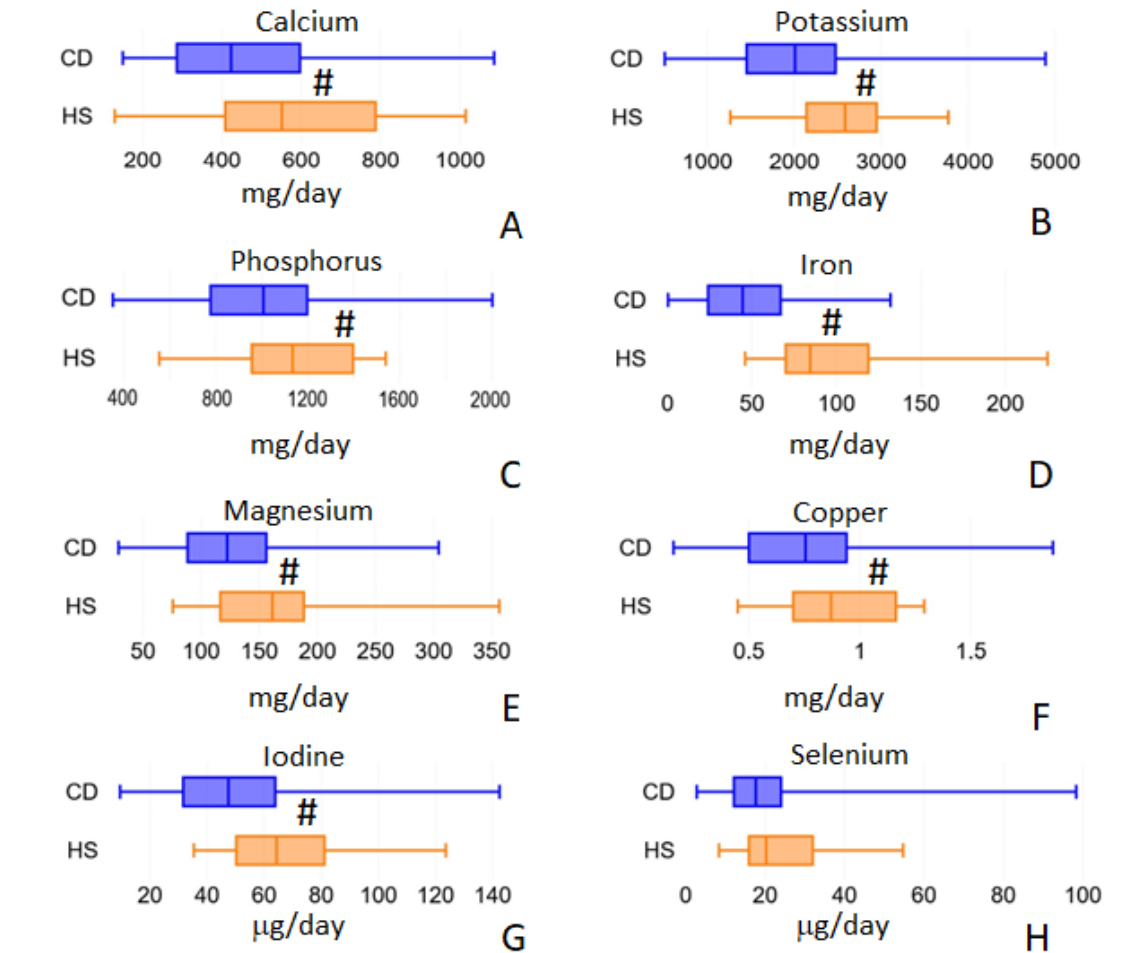
Figure 3. Minerals intake values that showed differences between the two populations under study: calcium (panel A ), potassium (panel B ), phosphorus (panel C ), iron (panel D ), magnesium (panel E ), copper (panel F ), iodine (panel G ) and selenium (panel H ). # = p < 0.01.